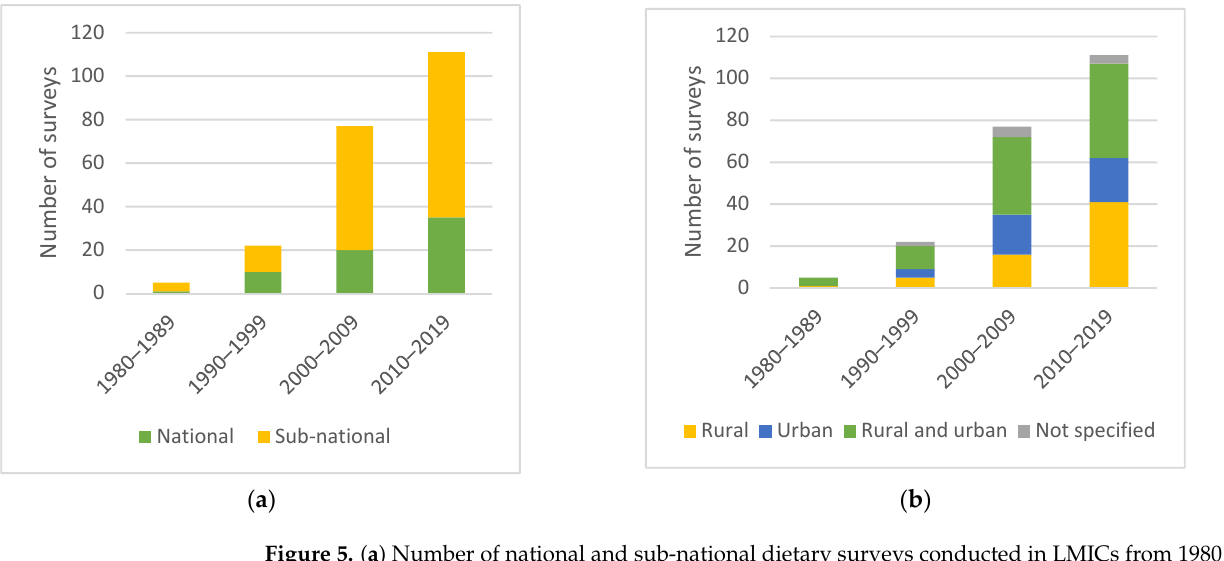
Figure 5. ( a ) Number of national and sub-national dietary surveys conducted in LMICs from 1980 to 2019 by decade, excluding longitudinal surveys. ( b ) Number of dietary surveys conducted in LMICs from 1980 to 2019 covering rural, urban, and rural and urban areas by decade, excluding longitudinal surveys. Data shown reflect the situation as of May 2022.